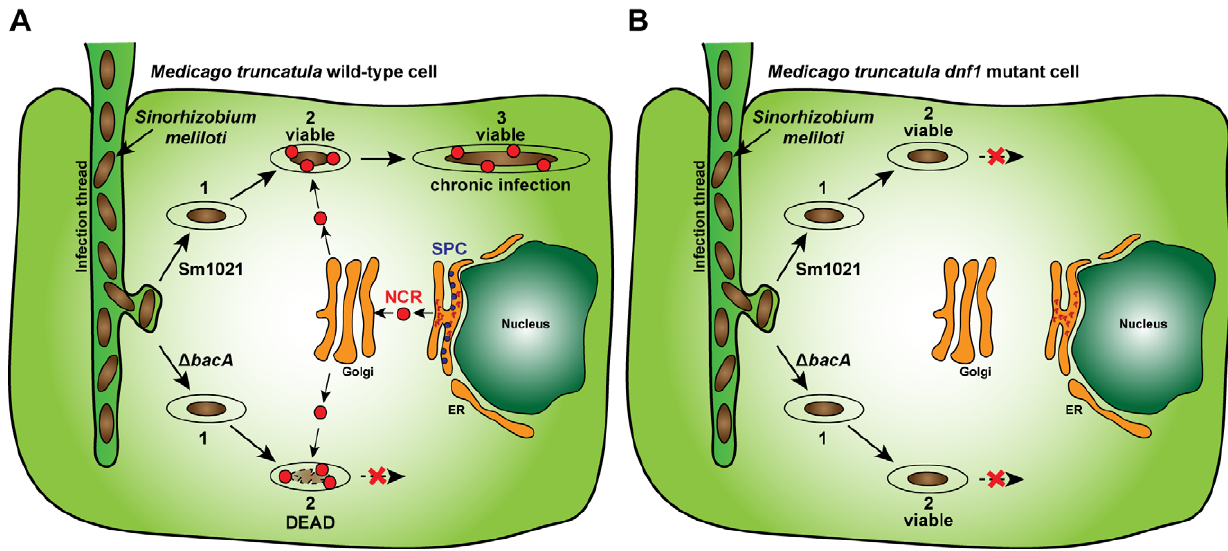
Figure 4. Hypersensitivity towards host AMPs prevents chronic bacterial infections. (A) In a wild-type M. truncatula nodule cell, the S. meliloti wild-type strain (Sm1021) and BacA-deficient mutant ( D bacA ) bacteria are released from the infection threads into the membrane-bound symbiosome (1). The bacteria are then challenged with host NCR AMPs (2), which mediate the differentiation of the wild-type strain into a nitrogen- fixing bacteroid, resulting in the chronic infection (3). In contrast, the BacA-deficient mutant is hypersensitive towards the host NCR AMPs and is killed by them rather than forming the chronic infection (2). (B) The M. truncatula dnf1 mutant is defective in a nodule-specific signal-peptidase complex (SPC) and as a result the NCR peptides are no longer transported to the bacterial compartment but are retained in the endoplasmic reticulum (ER) [4]. The S. meliloti wild-type strain and BacA-deficient mutant enter into the symbiosomes (1) and remain viable due to the absence of NCR peptide challenge (2). However, neither strain can differentiate into N 2 -fixing bacteroids due to the absence of NCRs.